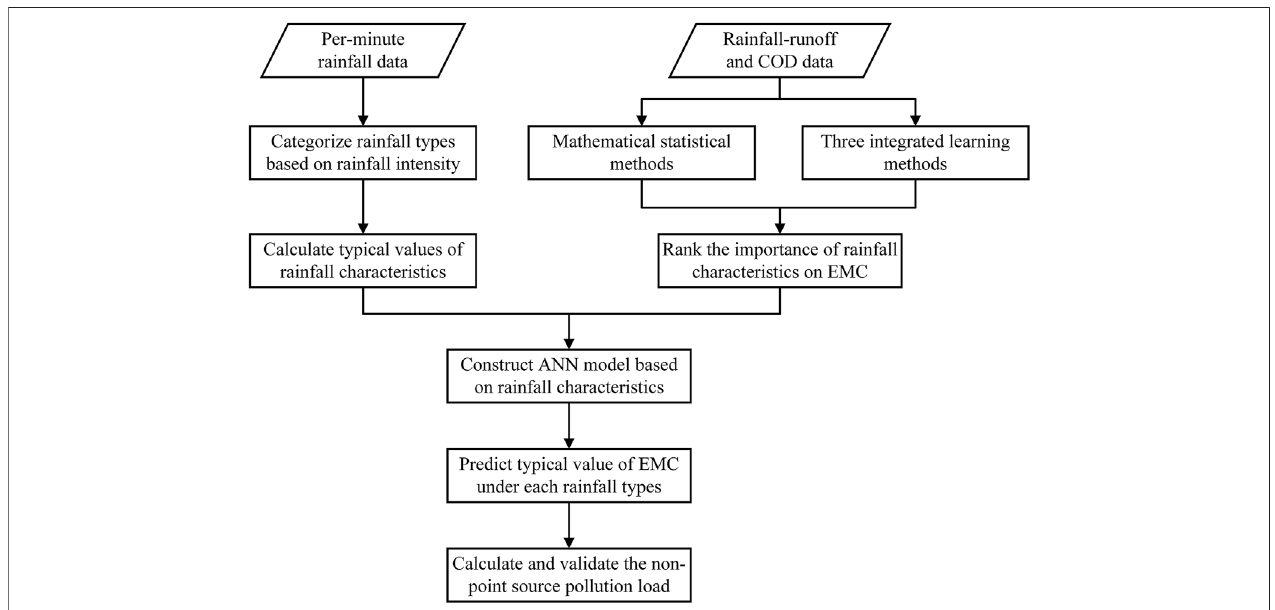
FIGURE 2 | Research framework for this